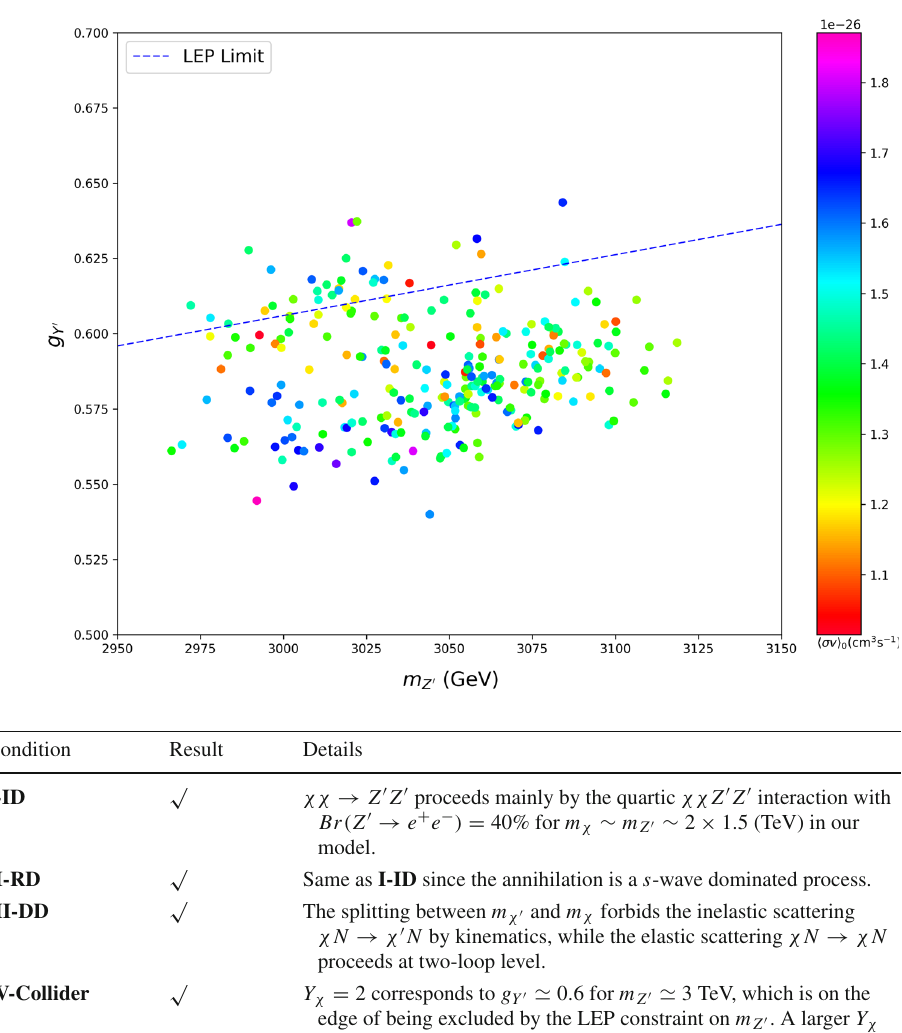
Fig. 3 Interpretation of the DAMPE excess by the samples satisfying the constraints from DM relic density and direct detection experiments, which are projected on g Y (cid:3) − m Z (cid:3) plane. The LEP-II bound on the plane is also plotted with the upper left region of the line